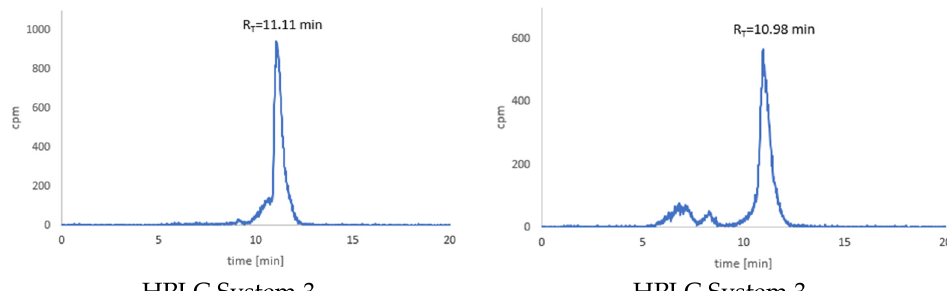
Figure 4. RP-HPLC radiochromatograms (System 3) of the stability studies of the 68 Ga-1 radioconjugate in Cys ( left , RCP 95.2 ± 1.5%, n = 3) and His ( right , RCP 76.2 ± 2.7%, n = 3) solutions recorded after 3.5 h of incubation.